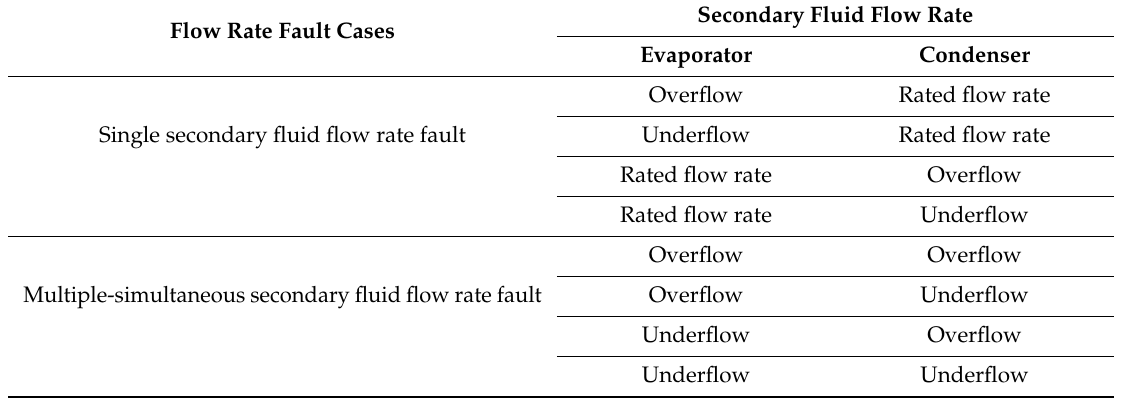
Table 2. The cases of secondary fluid flow rate faults.